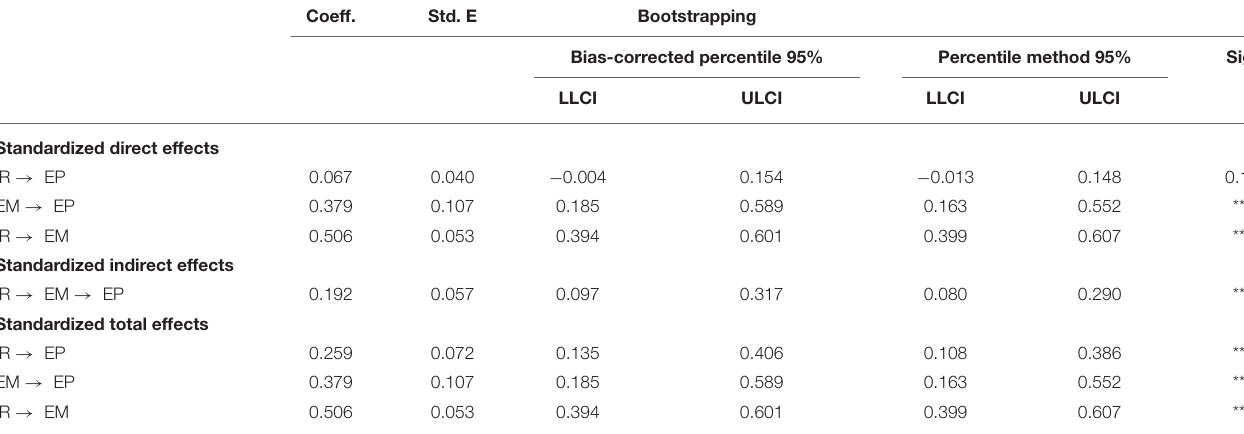
TABLE 7 | Results of bootstrapping for standardized direct, indirect, and total effects of the model. Coeff. Std.